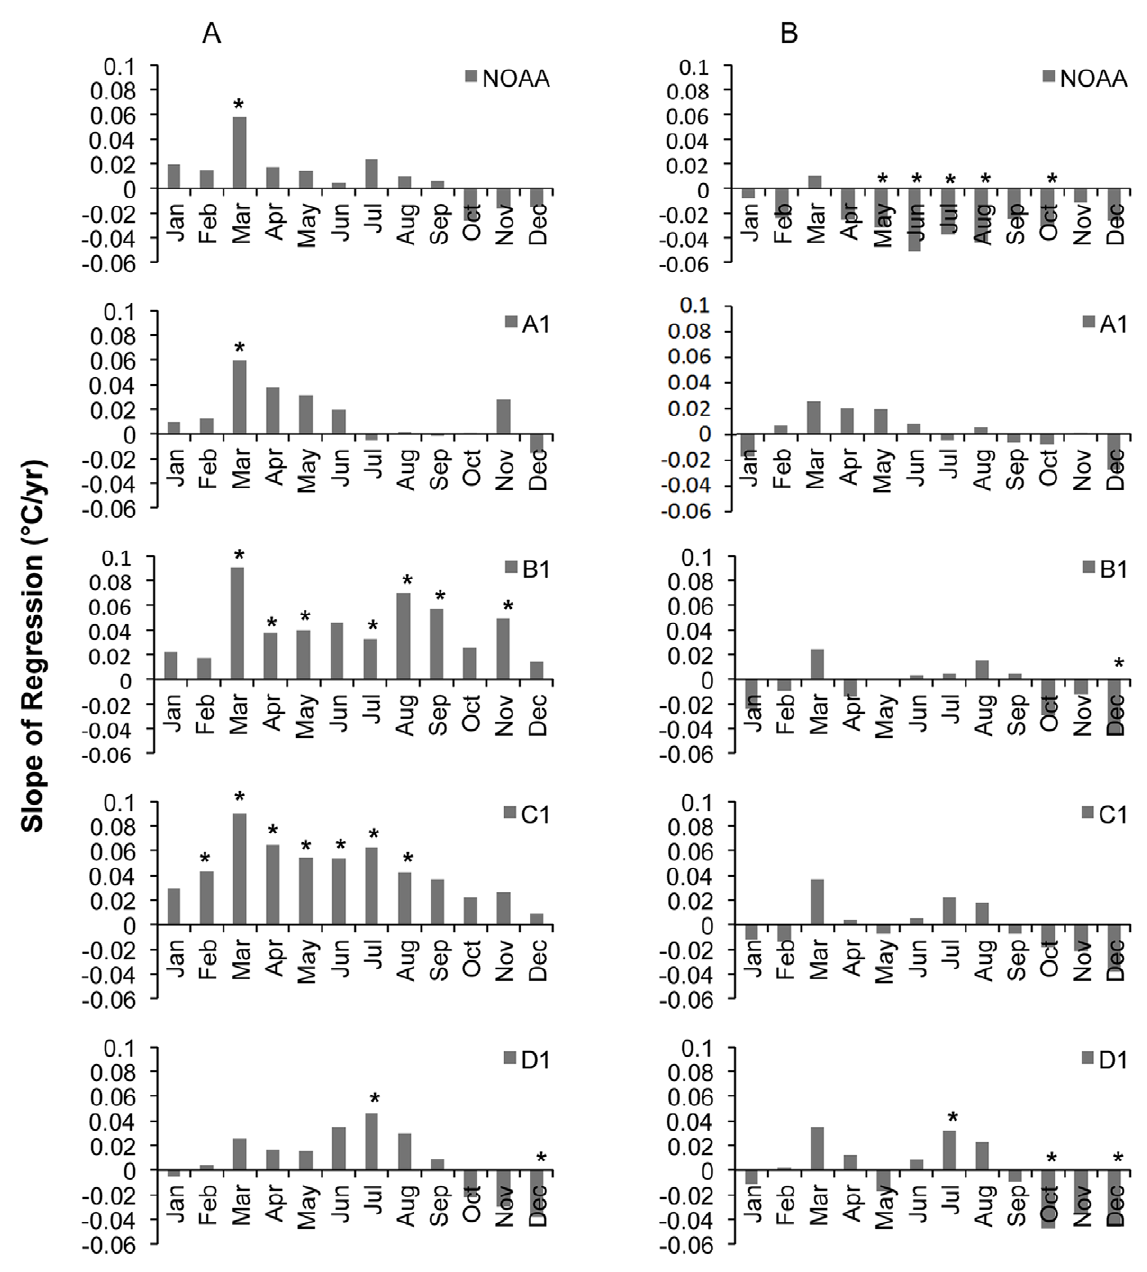
Figure 3. Monthly temperature trends derived by linear regressions over a fifty-six-year period (1953–2008) across the RMFR transect. Trends shown as changes in the average monthly (A) maximum and (B) minimum temperatures ( u C) per year. Significance level of regression denoted by * p , 0.05.